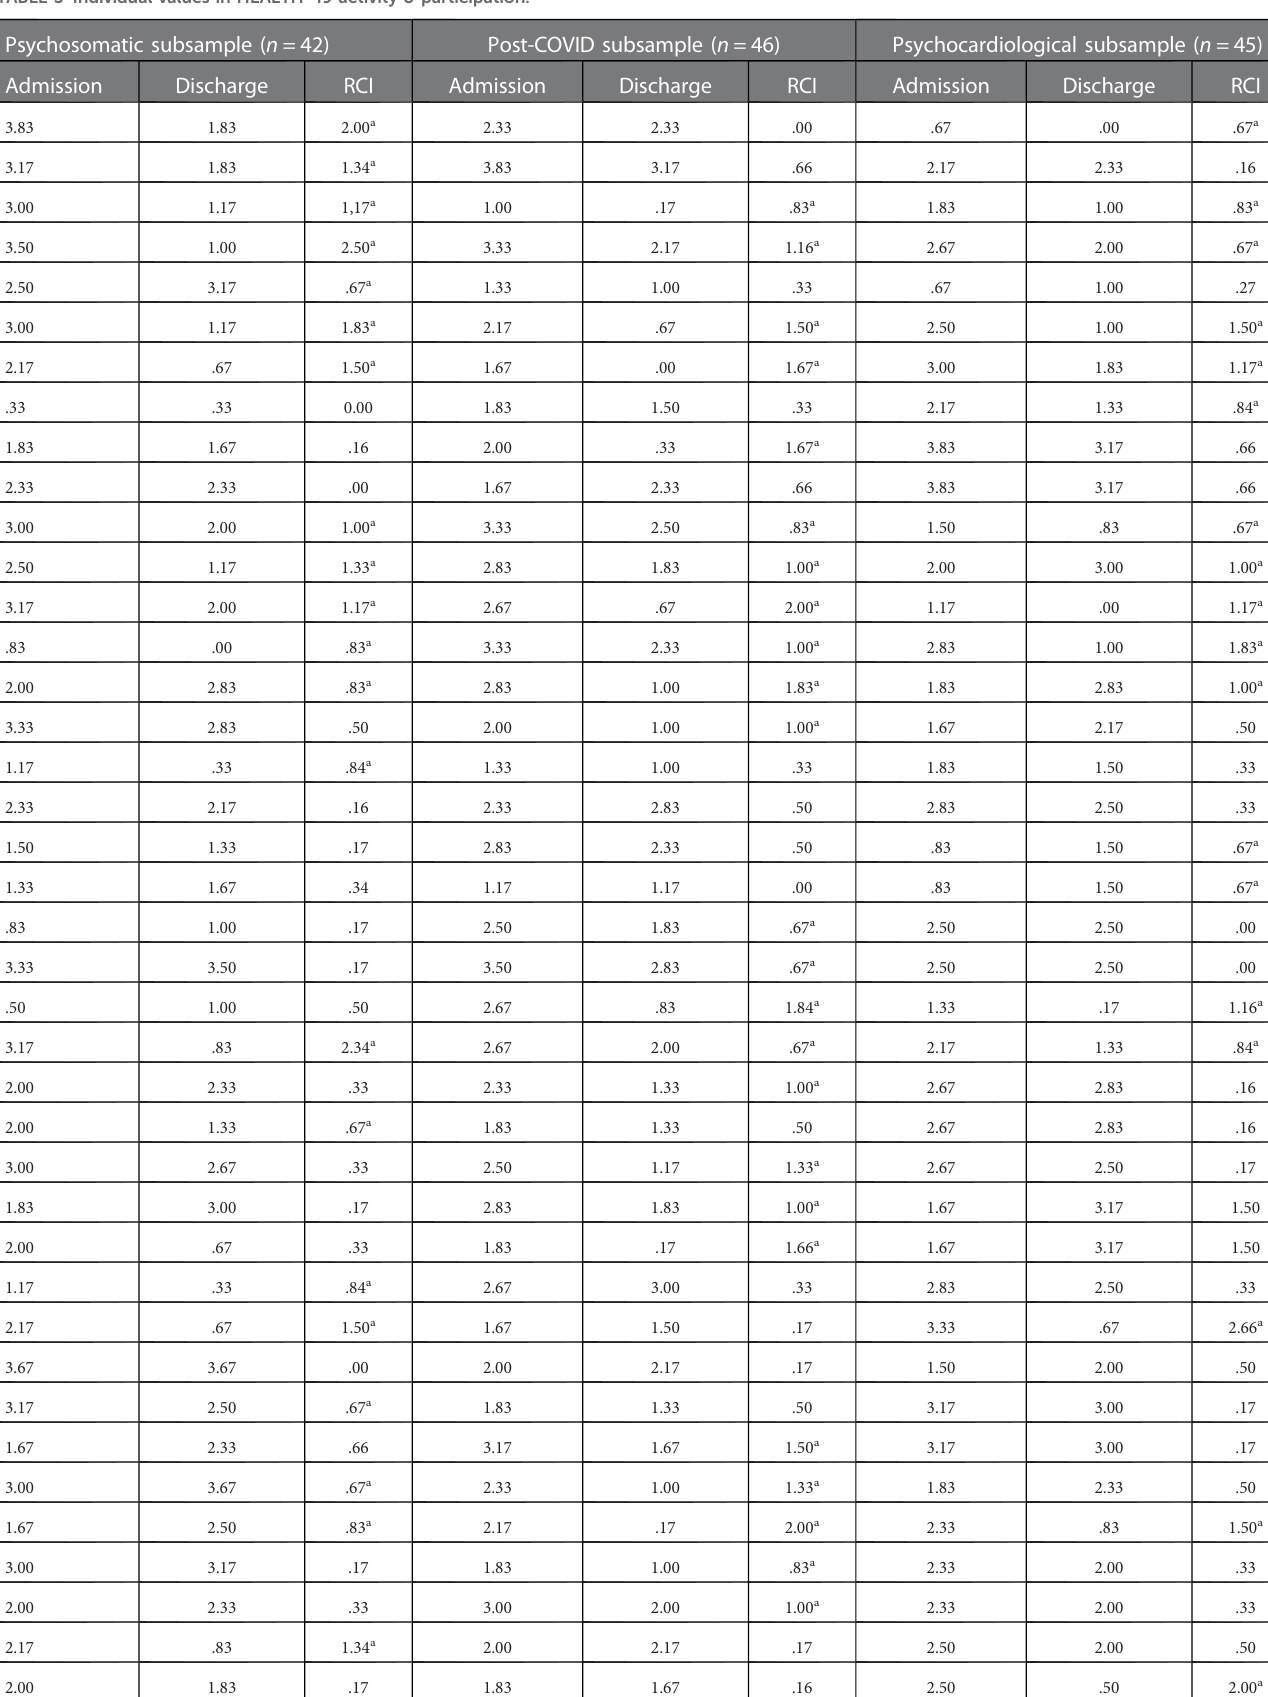
TABLE 3 Individual values in HEALTH-49 activity & participation. Psychosomatic subsample ( n =